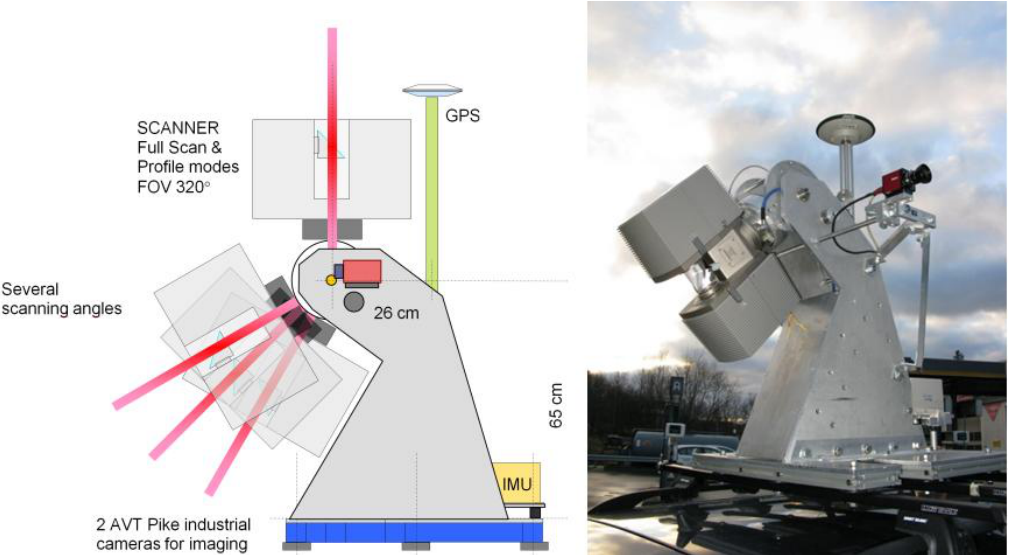
Figure 1. The FGI ROAMER system (photo from Kukko, A., 2009). Left : Side views of the platform design and instrumentation; Right : Image of the ROAMER (Here the scanner is tilted to the backward direction at a depression angle of 45°).